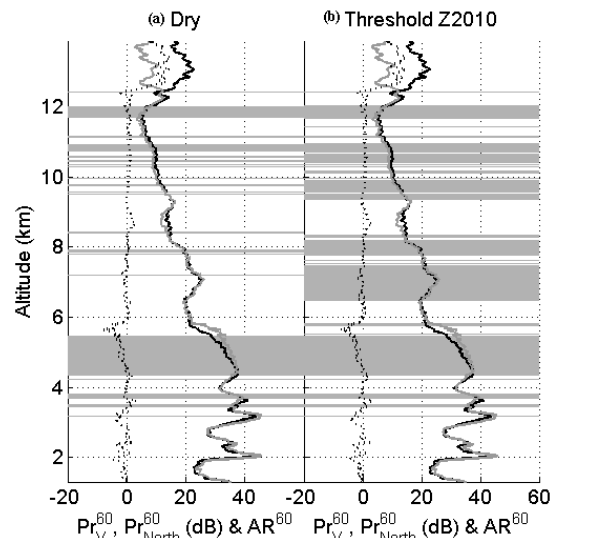
Fig. 3. (a) Vertical echo power profiles (averaged over 60min dur- ing the balloon flight 52 and corrected from range attenuation ef- fects) measured by MUR at vertical (black) and oblique (gray) (10 ◦ off zenith) incidences. The dotted black curve shows the aspect ratio i.e. the ratio between the vertical and oblique echo powers. The light gray rectangles show the detected overturning events by assuming a dry atmosphere. (b) Same as (a) , but balloon data analyses were performed by including the moisture effects.